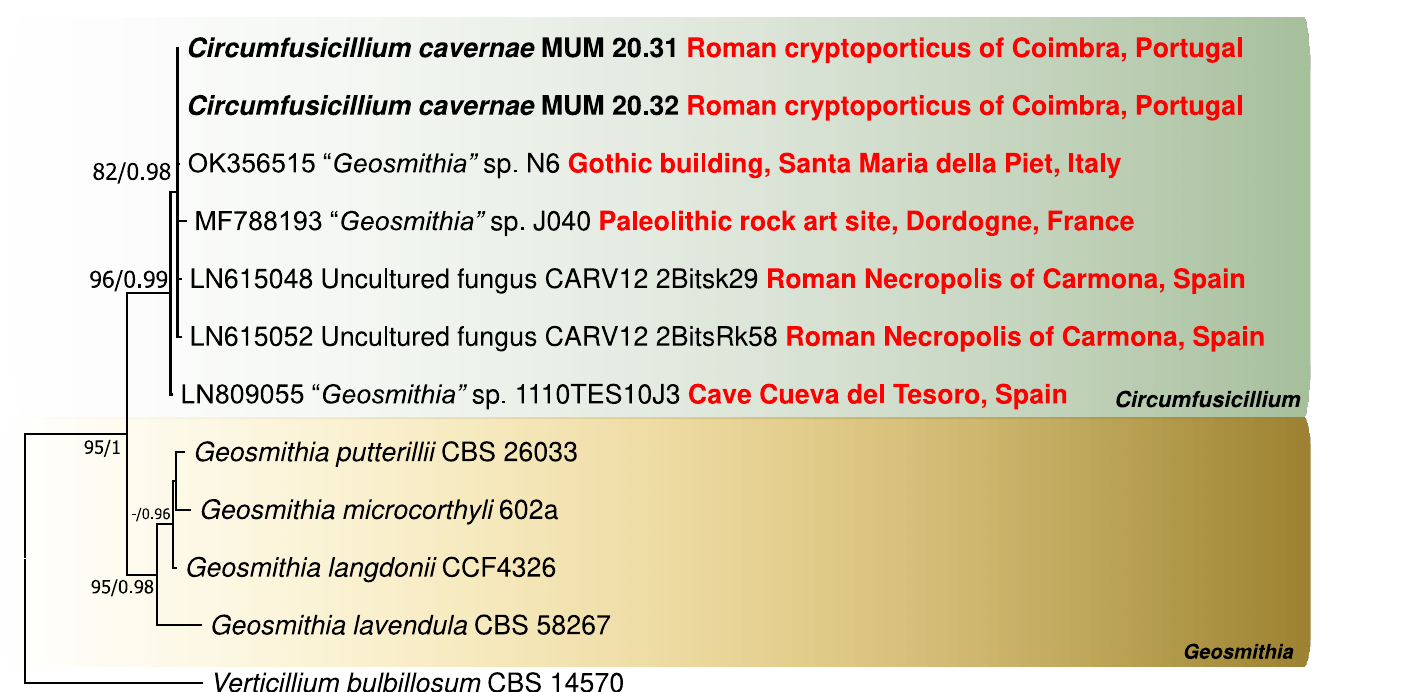
Figure 4. Phylogenetic trees obtained using best Blast hits ITS sequences and Geosmithia represent- atives. The new taxa are indicated in black and bold . The original study sites are presented in bold and red . The scale bar indicates the number of substitutions per site, and the support values (>75% bootstrap values for Maximum likelihood and >0.75 for Bayesian MCMC posterior probabilities) are also shown.